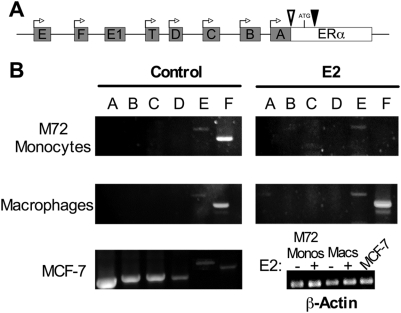
ERα promoter utilization in monocytes and macrophages.
A, schematic representation of the ERα promoter. Boxes A–F represent up-stream exons and forward arrows denote transcription start sites. The inverted open triangle indicates the primary splice acceptor site and the inverted closed triangle represents the alternative splice acceptor site responsible for ERα46 message. Exons E and F splice into exon E1 before splicing to the ERα coding sequence. B, cells were treated as in Figure 2 and RT-PCR analysis was performed using forward primers specific for each upstream exon and a reverse primer specific for exon 2 (see Table 1) to determine ERα promoter usage. Reactions for β-actin were used as a control for cDNA integrity.